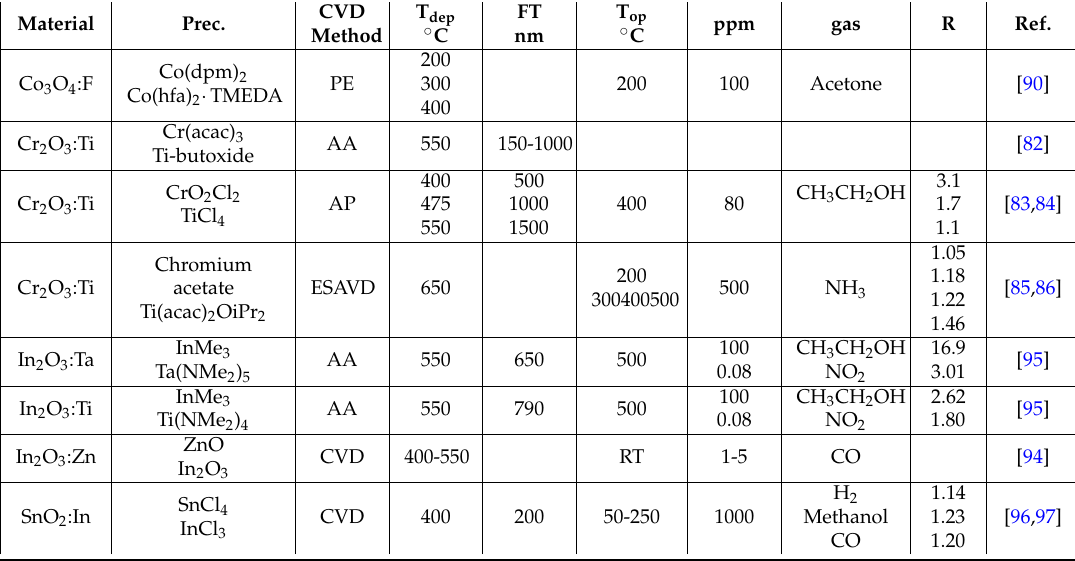
Table 4. Summary of the features and sensing properties reported for chemical vapour deposited complex metal